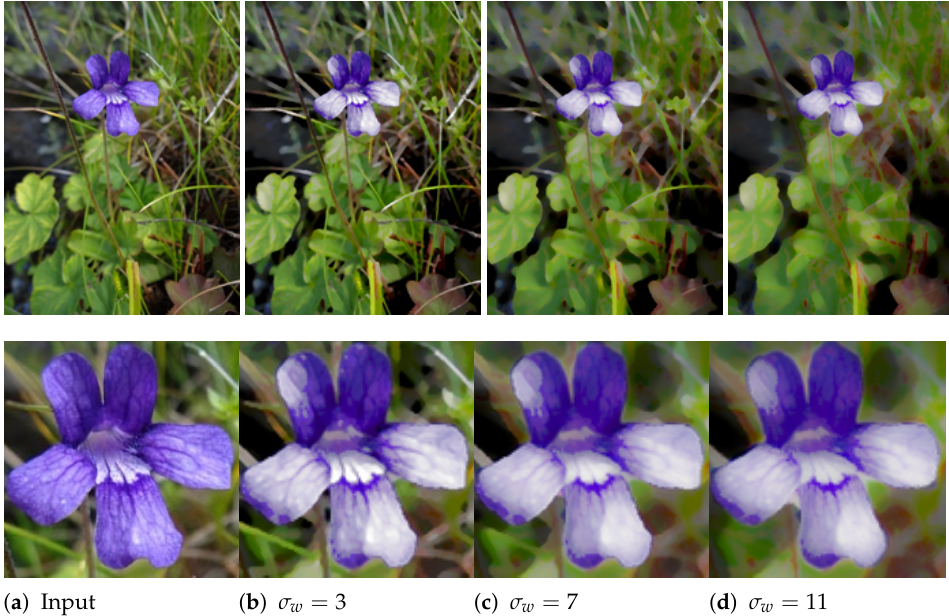
Figure 3. Impact of smoothing by augmenting the Gaussian kernel W with a flower picture ( top ) and a zoomed part of it ( bottom ).